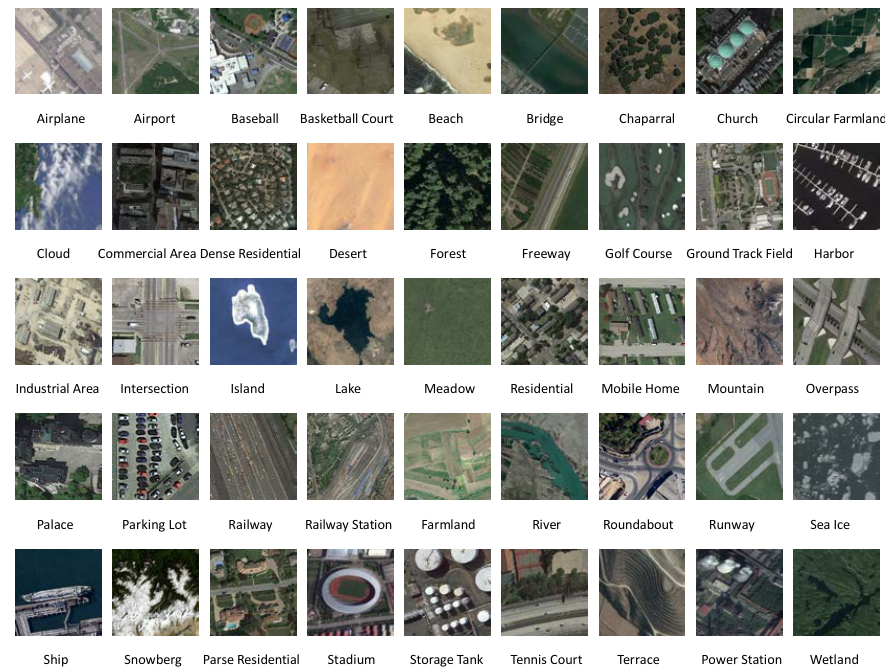
Figure 4. Example images of the Northwestern Polytechnical University (NWPU)-RESISC45 dataset.